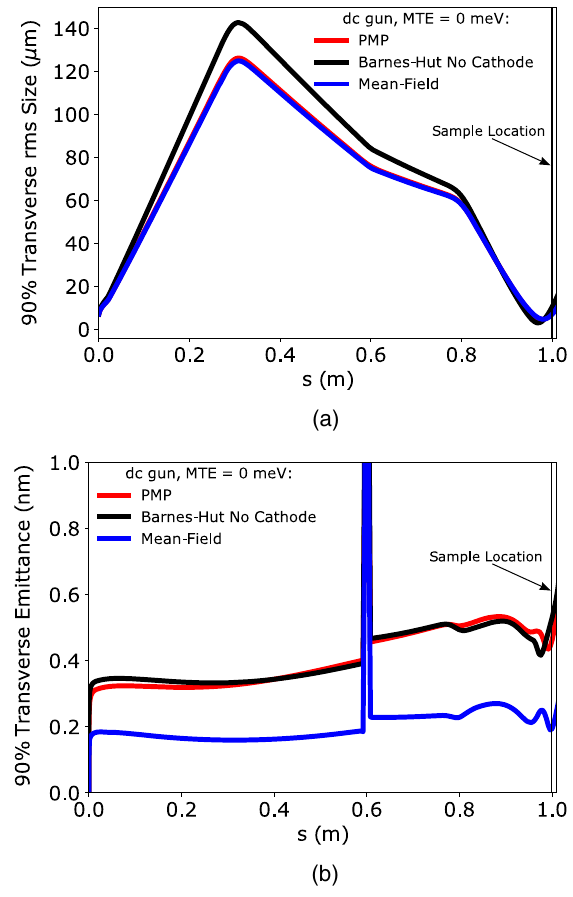
FIG. 4. (a) Spot size and (b) transverse normalized rms emittance comparison between the PMP method, Barnes-Hut method without a cathode, and mean-field space charge simu- lations of the dc UED beam line with 0 meV